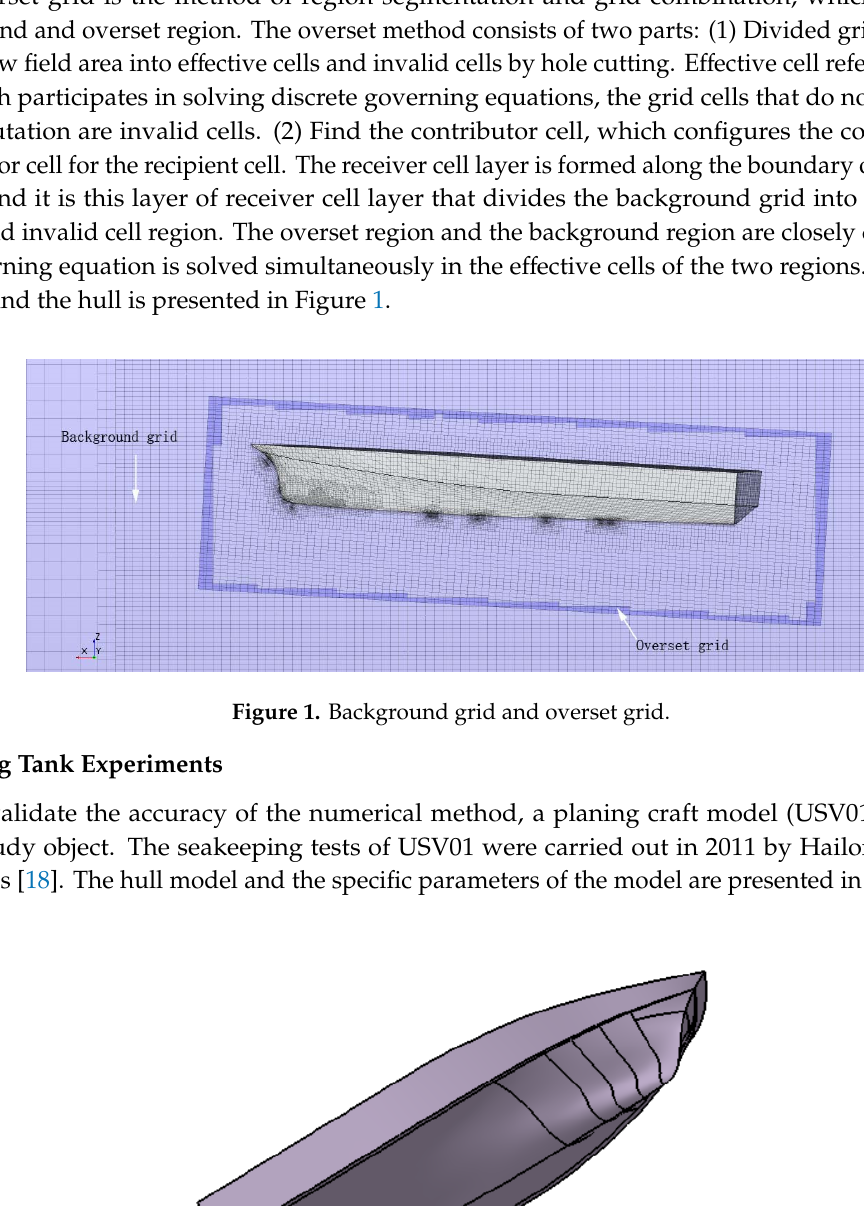
Figure 2. Three-dimensional (3D) model of the USV01 Figure 2. Three ‐ dimensional (3D) model of the USV01 model.